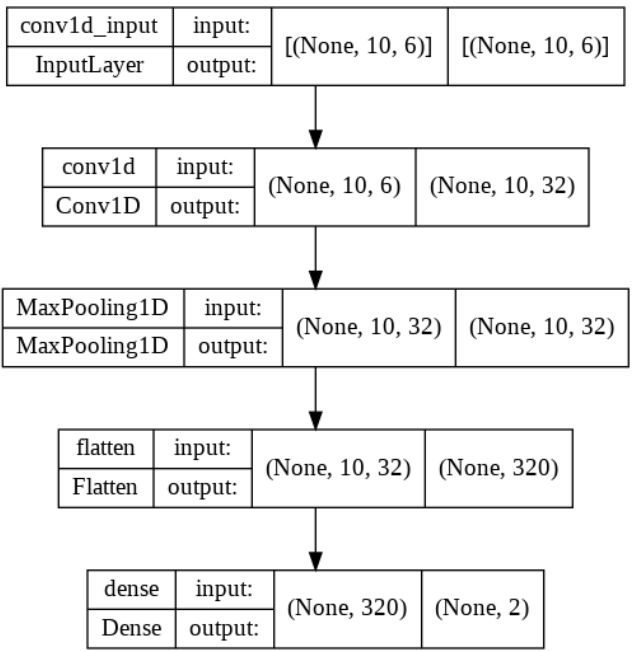
Figure 5. CNN Model